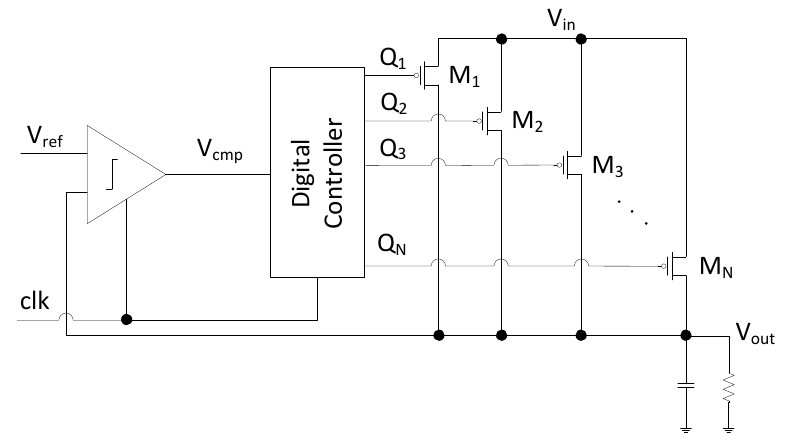
Figure 1. Schematic of a DLDO voltage